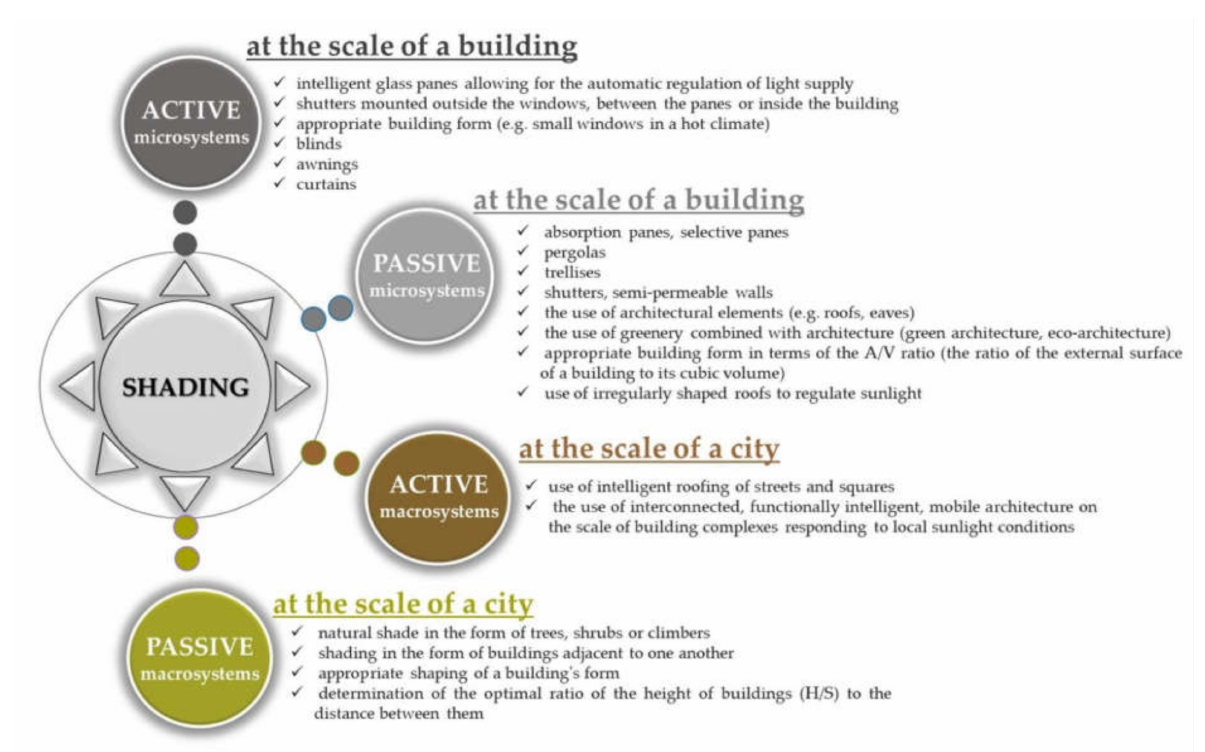
Figure 4. Multi-scale systems of passive and active shading on micro- and macroscales